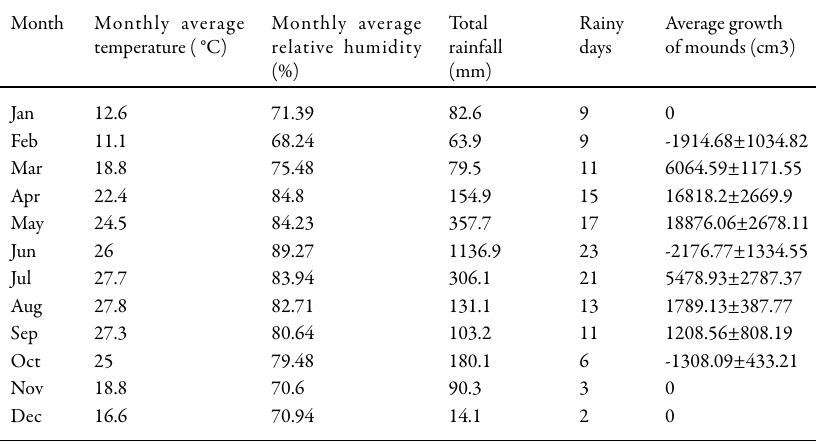
table 2 .The relationship between mound growth and climatic